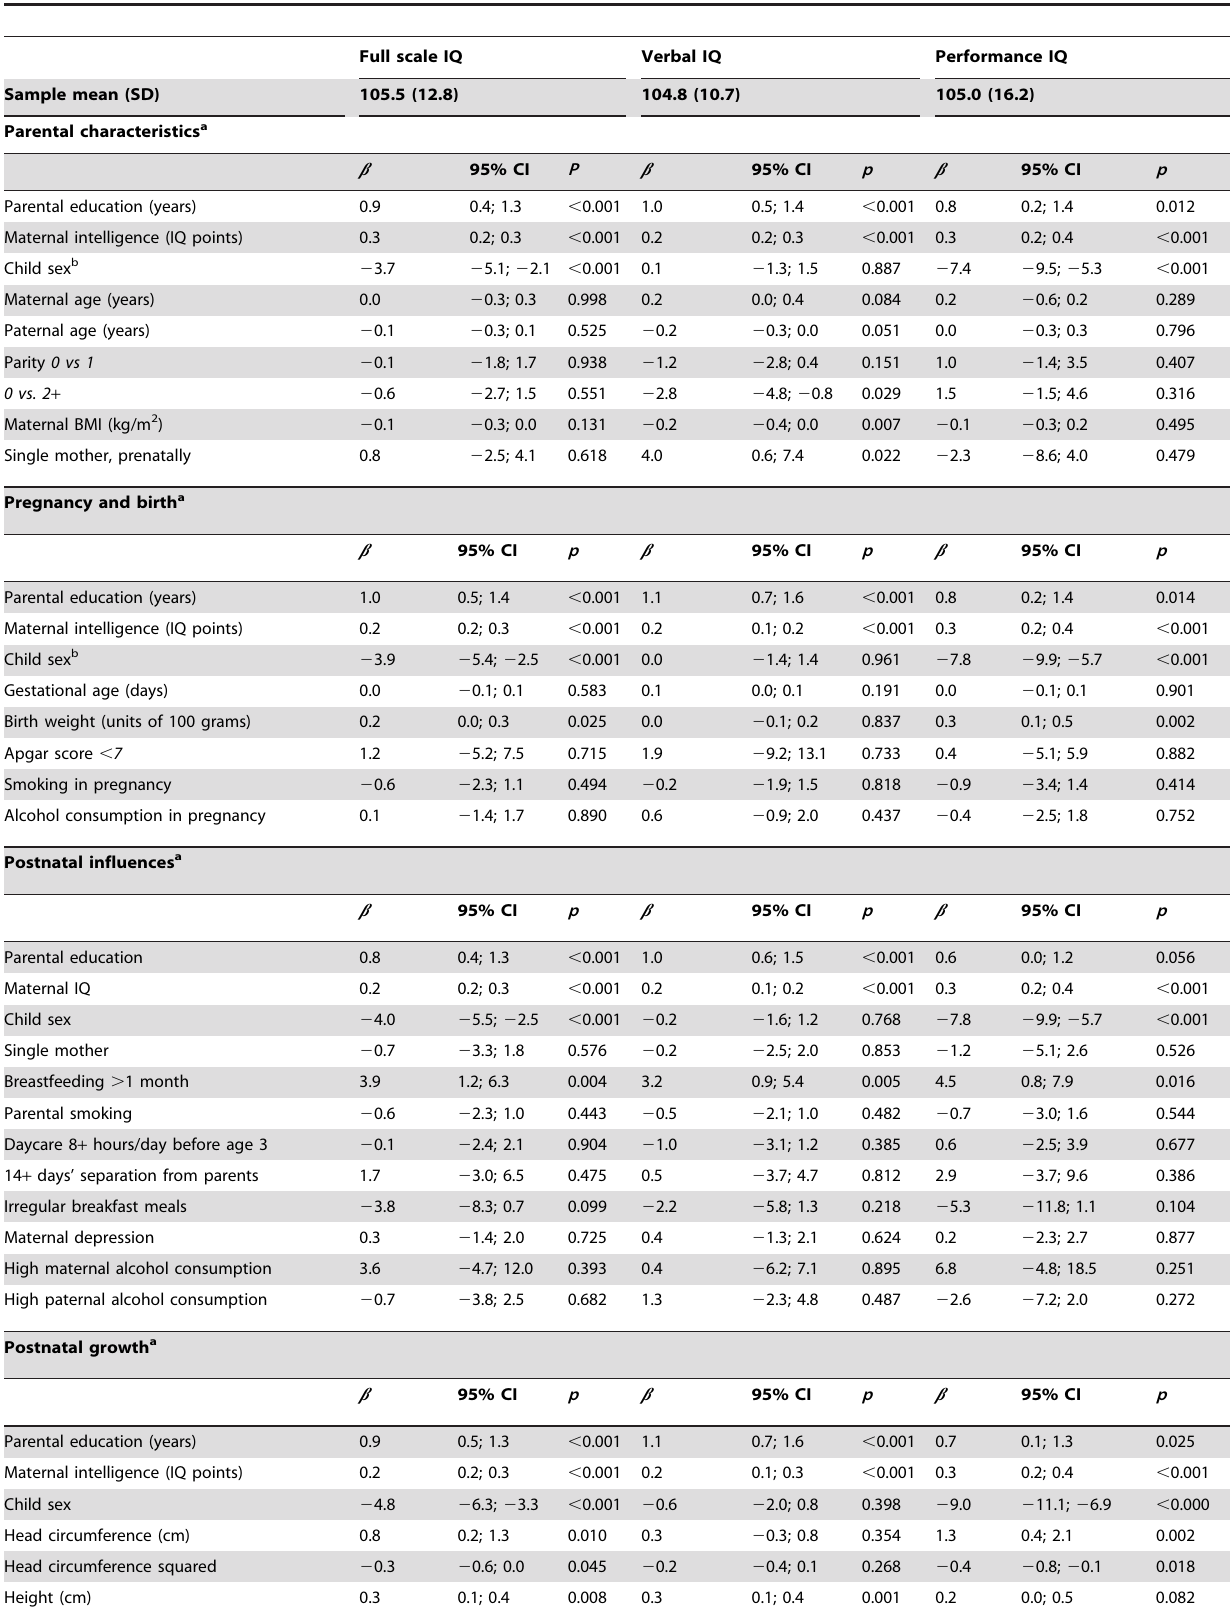
Table 2. Predictor variables and WPPSI-R scores within predictor domains, Denmark